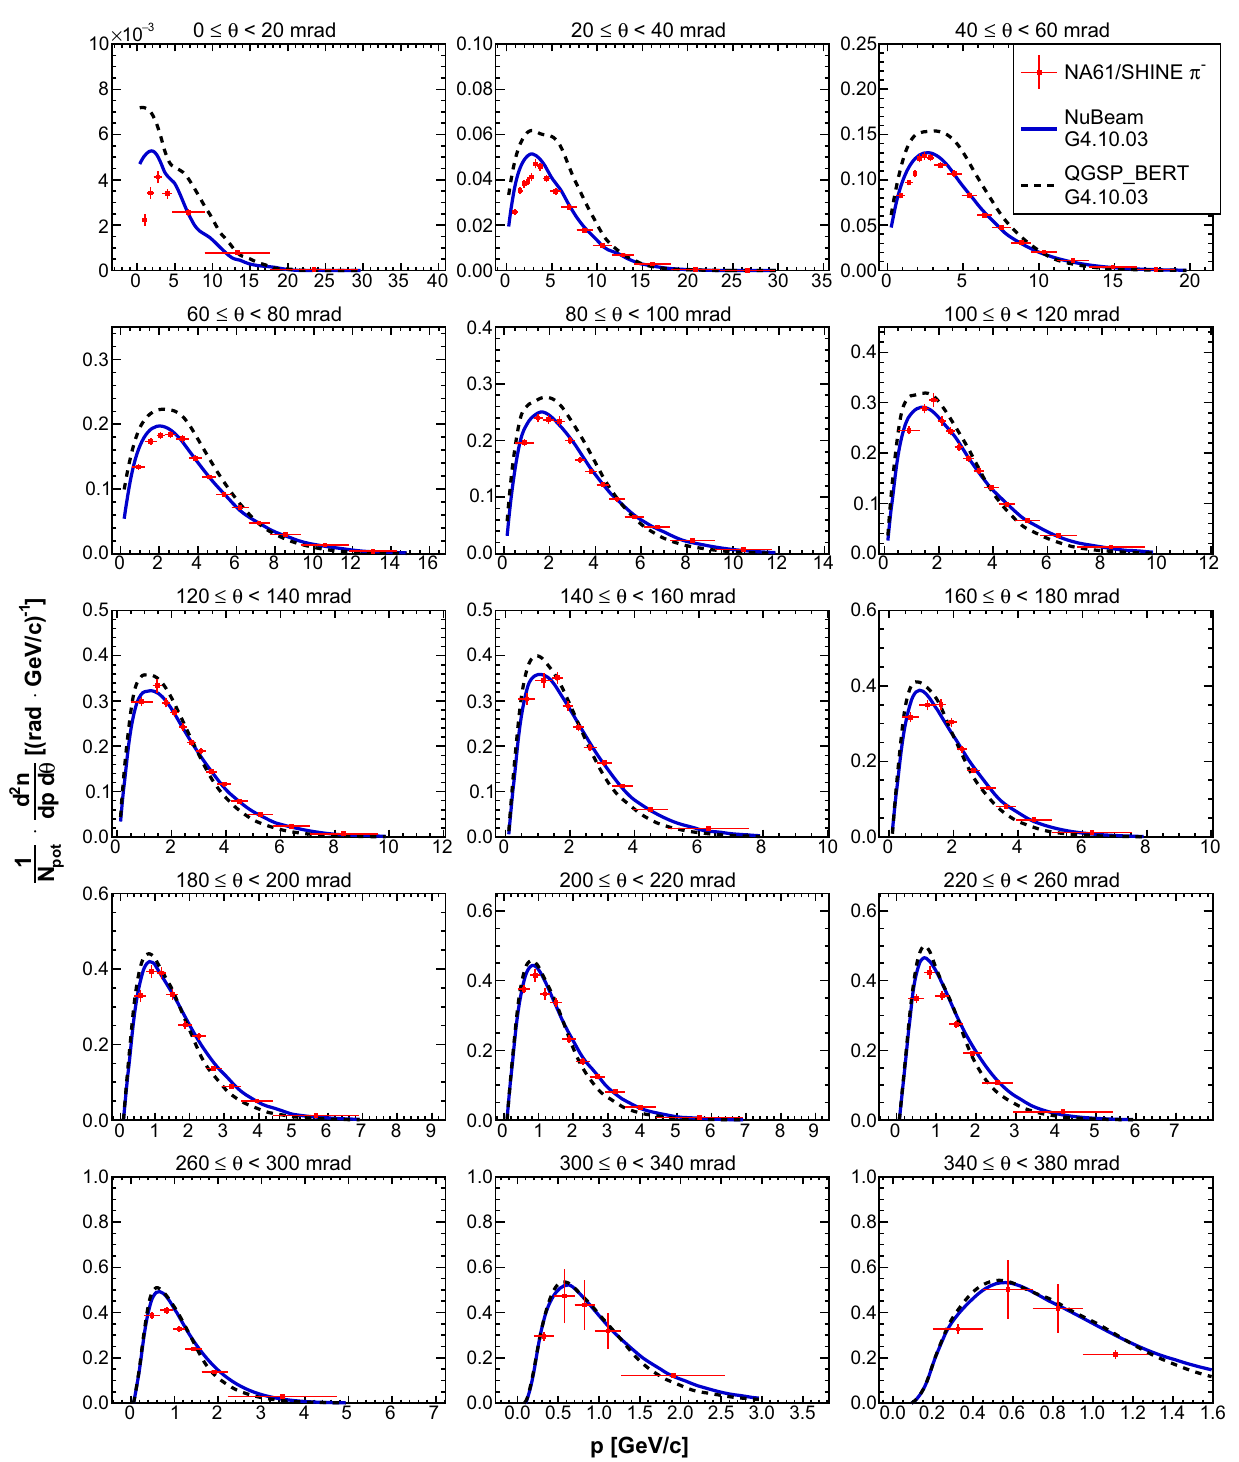
Fig. 31 Double differential yields of negatively charged pions for the third upstream longitudinal bin (36 ≤ z < 54 cm). Vertical bars represent the total uncertanties. Predictions from the NuBeam (solid